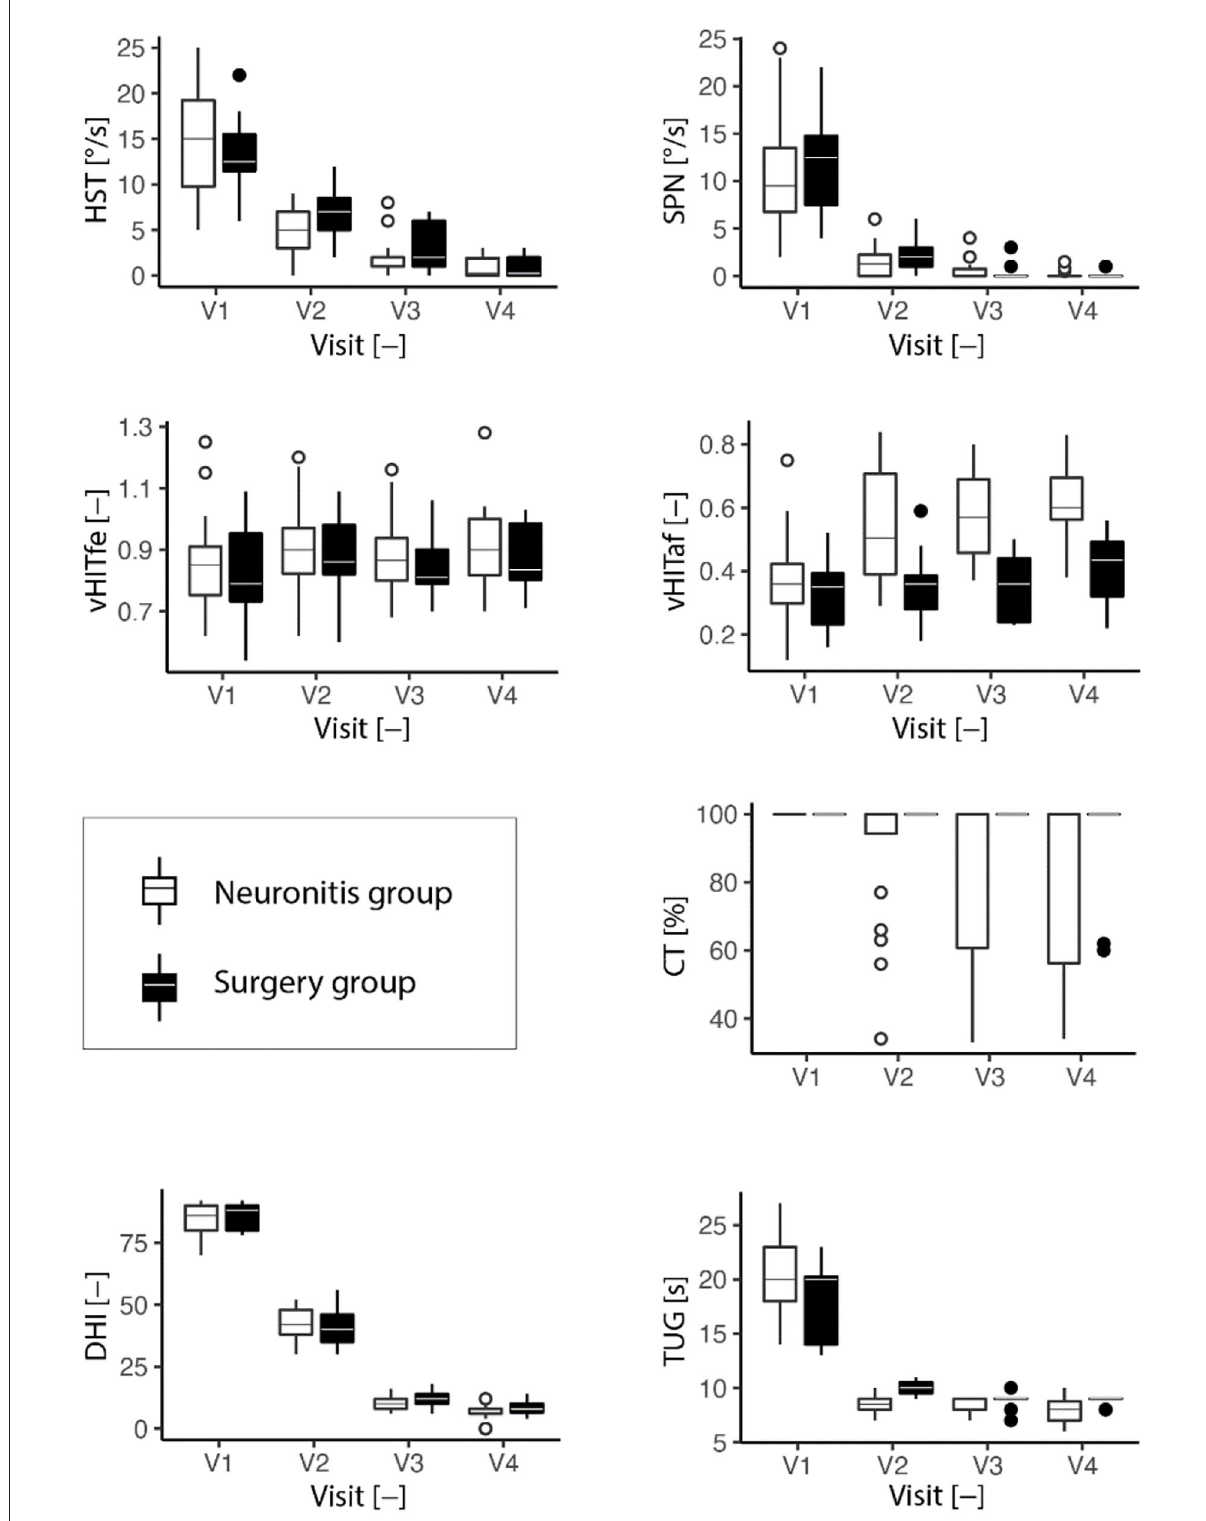
FIGURE2 Development of the vestibular tests (HST, head-shaking test; SPN, spontaneous nystagmus; vHITfe(af), video head impulse test on the affected (fellow) side; CT, caloric test; TUG, timed up and go test; DHI, dizziness handicap inventory) over four visits (the last visit). Descriptive characteristics are listed for each visit (2 years). The box plots are depicted. In the boxplots, the bottom line of the box represents the first quartile, second (middle of the box) median, third (top of the box) quartile, and the whiskers extend to the most extreme data point, but no more than one and half of the interquartile